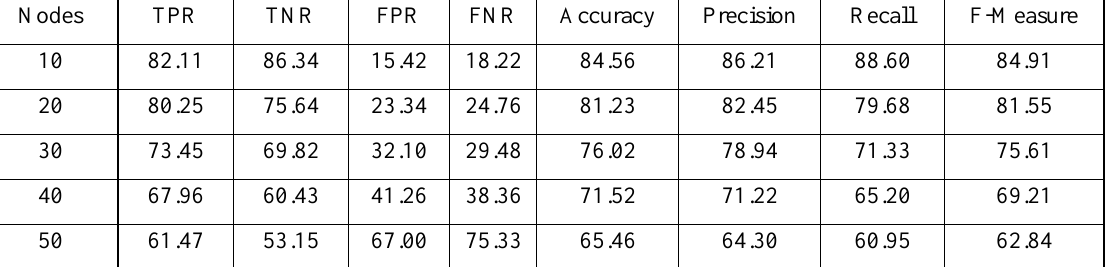
Table 2. Results of the various metrics at different nodes with proposed FSDAA in percentage at selected region